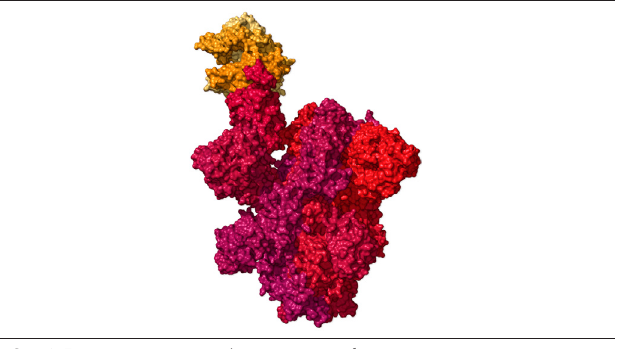
FIGURA 3 – União entre a proteína S e o receptor da ACE2 A ACE2 está representada pela cor amarela e corresponderia ao USB de um computador. ACE2: enzima conversora de angiotensina 2.